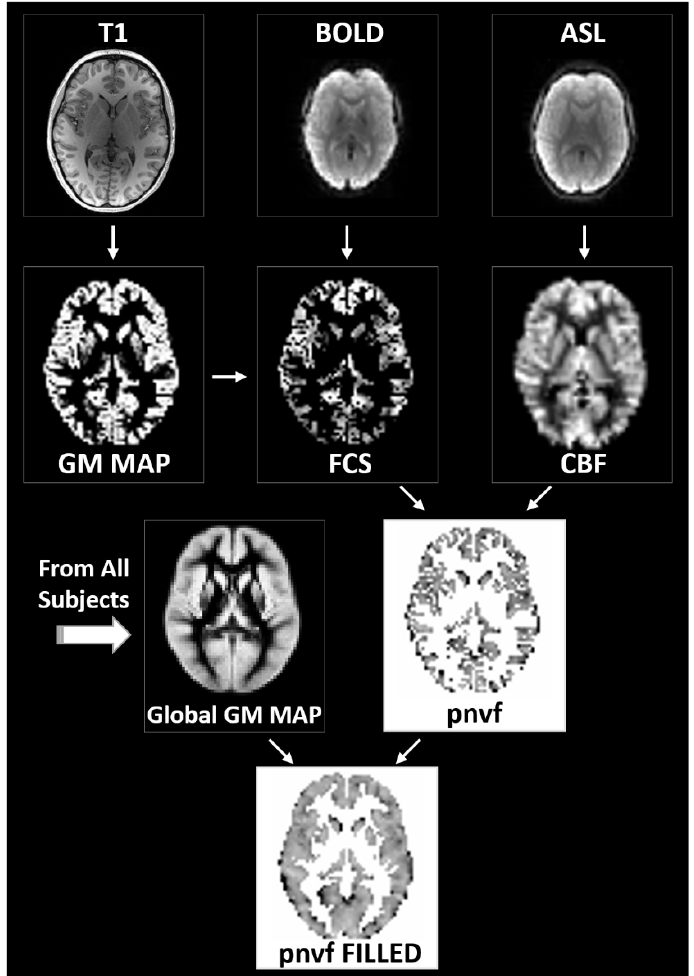
Figure 1. Flowchart of the data processing routines for the estimation of the proxy for neurovascular function (Pnvf). Gray matter voxels are determined via segmentation of the whole-brain anatomical T1 images ( left ). From the BOLD resting-state data, functional connectivity strength (FCS) is computed voxelwise as the average correlation coefficient between a gray matter voxel time course and the time courses of all other gray matter voxels ( center ). From the ASL data, cerebral blood flow (CBF) maps are computed based on the difference between the labeled and unlabeled acquisitions ( right ). All maps are transformed into standardized Montreal Neurological Institute (MNI) space. Pnvf is computed on a voxelwise basis as the negative of the FCS/CBF ratio for all voxels in the global gray matter mask; missing values are filled in via trilinear interpolation ( bottom ).